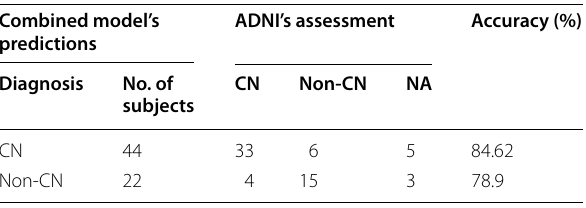
Table 6 Combined model’s prediction accuracy by category at